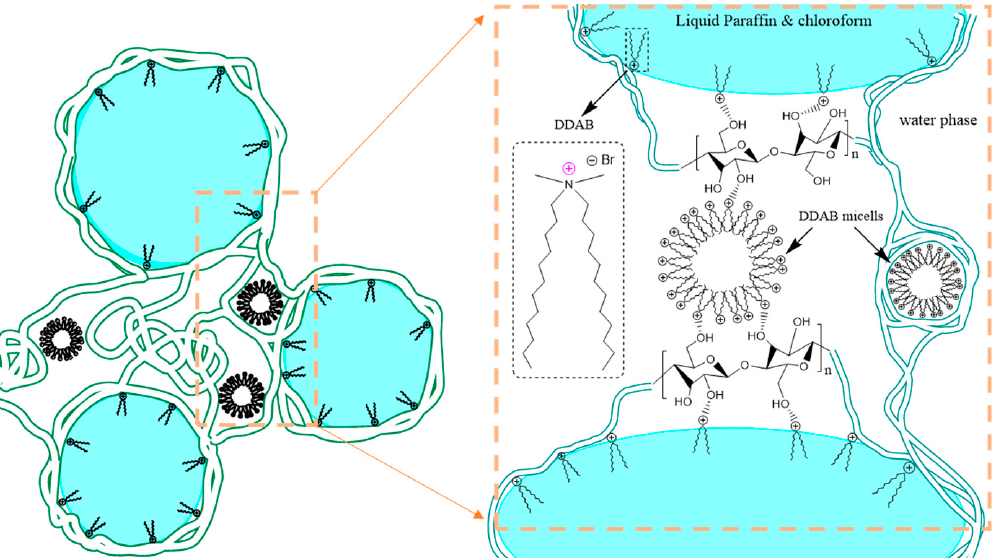
Figure 1. Schematic representations of CNF emulsion droplets, including the three CNF-crosslinked droplets, adsorbed DDAB molecules, and attached micelles, and the corresponding detailed interfacial structure showing hydrogen bonding between the DDAB molecules and the CNF.